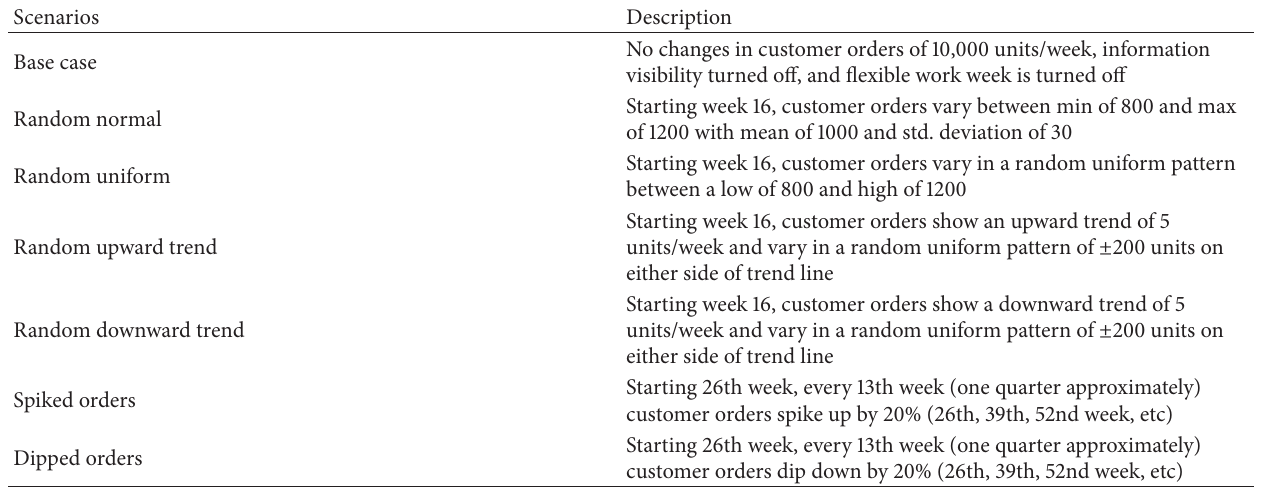
Table 2: Customer order scenarios